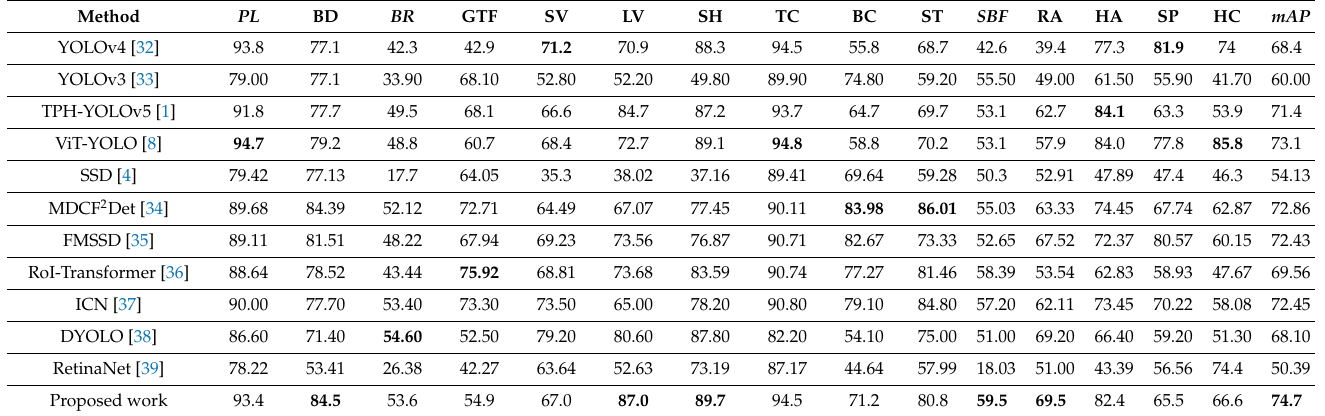
Table 6. Comparison of the performance of other